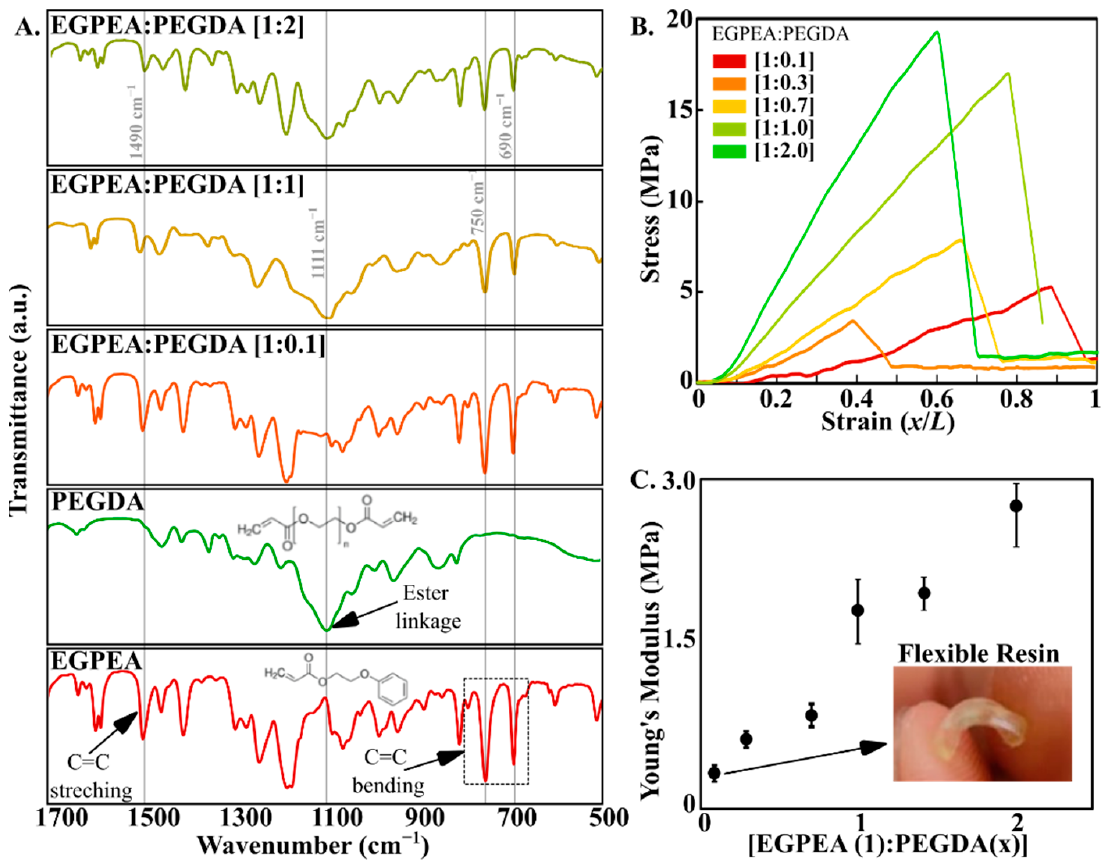
Figure 5. ( A ). FTIR spectra of custom resin formulations with varying amounts of EGPEA and PEGDA. ( B ). Stress-strain profiles, obtained from tensile stress tests performed on custom resin prints. ( C ). Young’s modulus of custom resin prints as function of varying PEGDA concentration.